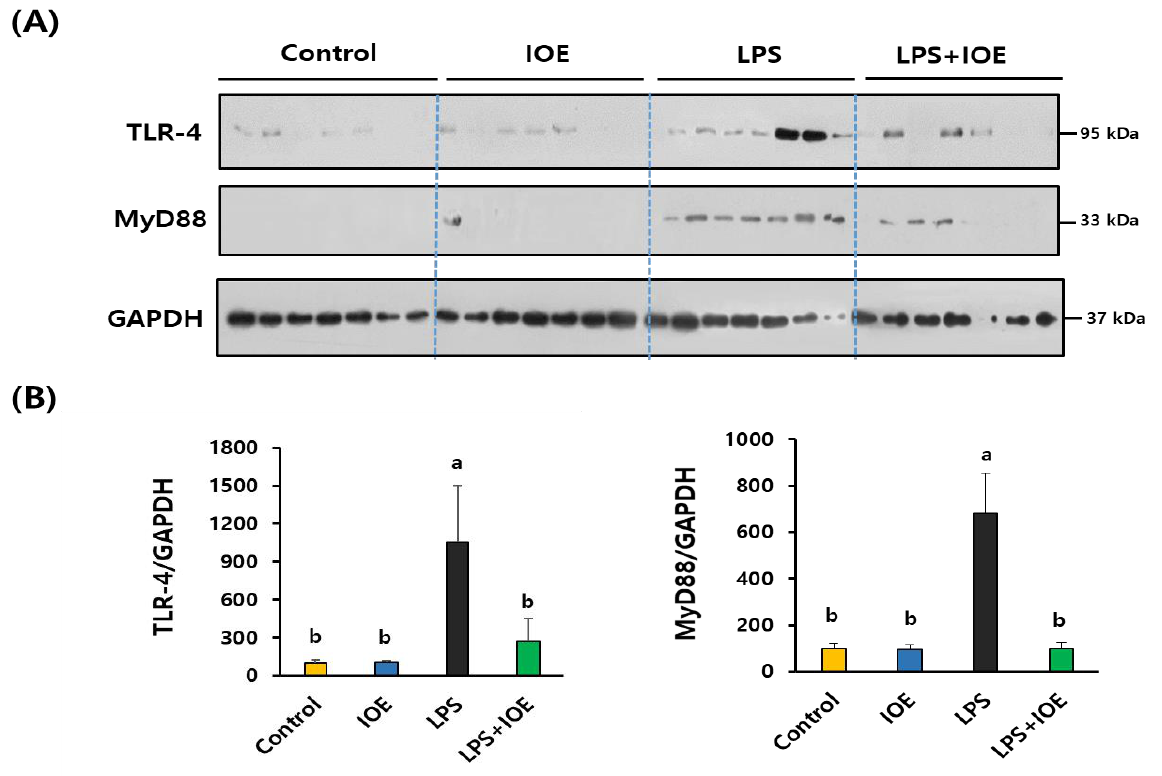
Figure 5. The expression of TLR-4 and MyD88 in brain tissue of LPS-injected mice was attenuated by oral administration of IOE. Total protein was extracted from brain tissues of each mice group and used for estimating the expression of TLR-4 and MyD88 through western blotting ( n = 7) ( A ). The density of each band was calculated by using Image J program and tabulated ( B ). Data shown are the mean ± SD and different letters (a,b) indicate the significant differences between groups ( p < 0.05). Each value is assigned as a and b sequentially from the highest value.